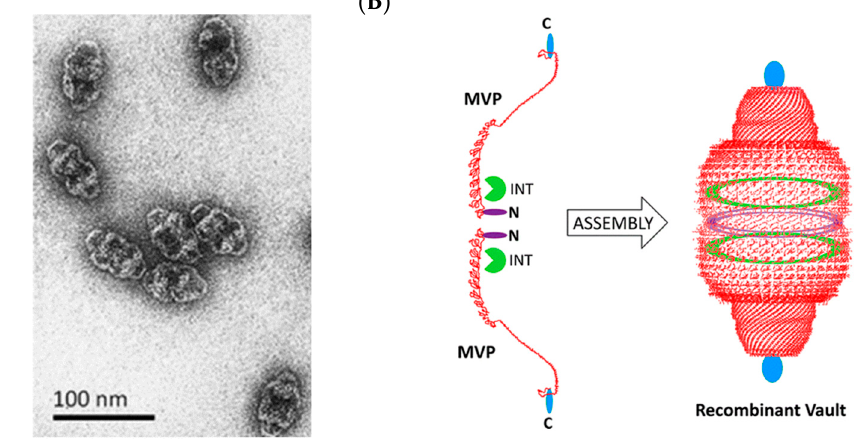
Figure 9. Vault complexes as an emerging eukaryotic-derived shell for biomolecular scaffolding. ( A ) TEM micrographs of vault. ( B ) Schematic view of vault, indicating the N- and C-termini along with the INT binding region. These are regions for modification of the vault shell. Reprinted from Kickhoefer and co-workers [119]. Copyright 2017 American Chemical Society.